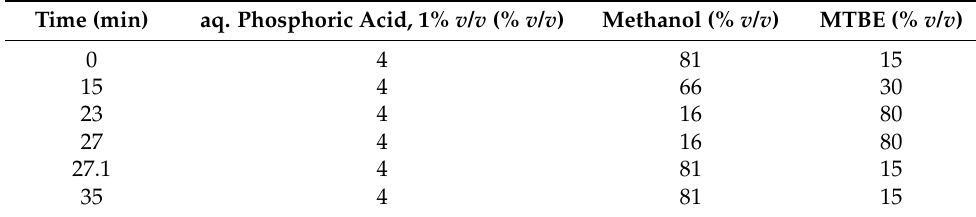
Table 1. The linear gradient adjusted for the RP-HPLC analysis. Time (min) aq. Phosphoric Acid, 1% v / v (% v / v ) Methanol (% v / v ) MTBE (% v / v )